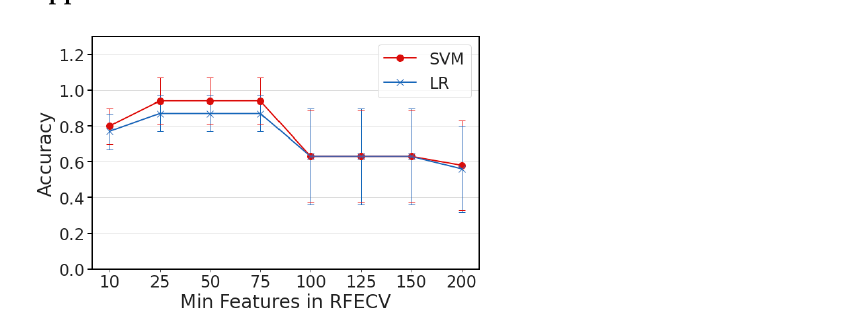
Figure A1. Classification accuracy compared with the minimum number of features to select.